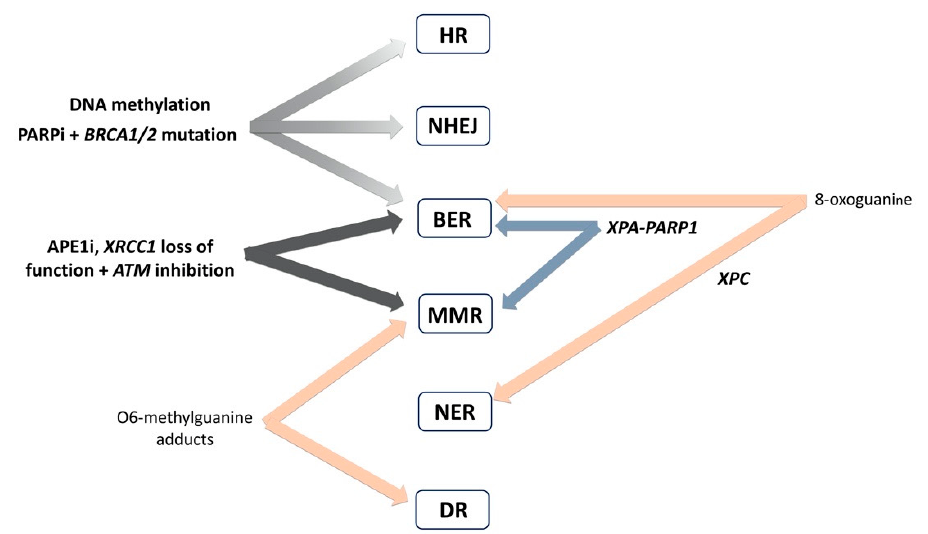
Figure 8. Interplay of DNA repair pathways. Simplified scheme of interactions between proteins from distinct DNA repair pathways (genes interacting in OvC in bold ). Gene names: breast cancer 1 and 2 ( BRCA1 and 2 ), X-ray repair cross-complementing 1 ( XRCC1 ), Ataxia telangiectasia mutated ( ATM ), xeroderma pigmentosum complementation group A and C ( XPA and C ), poly(ADP-ribose) polymerase 1 ( PARP1 ). Protein inhibitors: apurinic / apyrimidinic endonuclease 1 inhibitors (APE1i), poly(ADP-ribose) polymerase inhibitors (PARPi).